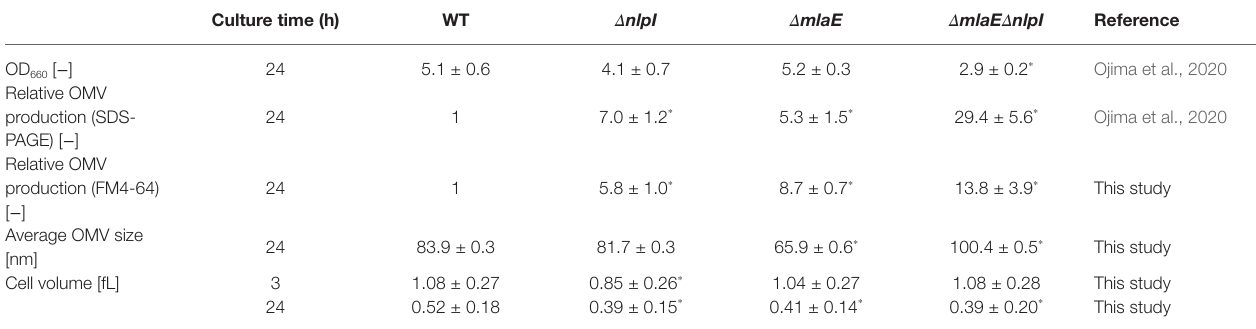
The data were obtained from three independent experiments (n = 3). The values of average OMV size are the means of average values from three independent experiments. The dimensionless quantity was indicated by the symbol [ − ]. The statistical differences were found between WT values and the values marked with asterisks determined by the Student’s t-test (p < 0.05).